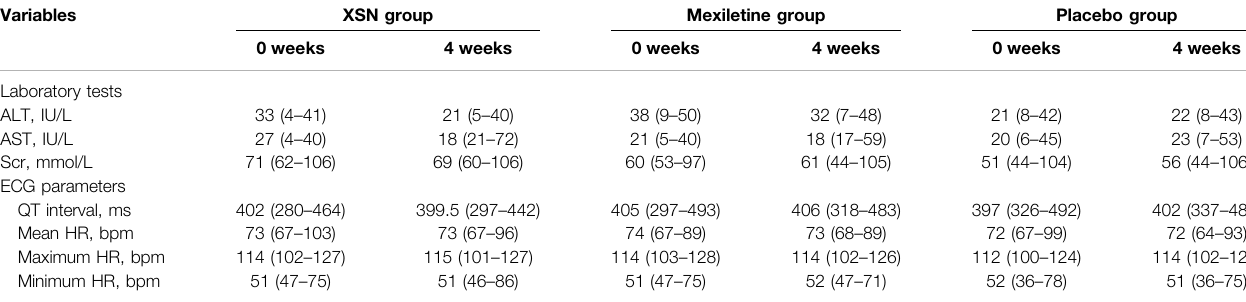
TABLE 1 | Laboratory evaluations and ECG parameter changes between the two groups, medium (range) (Ma et al., 2020). Variables XSN group